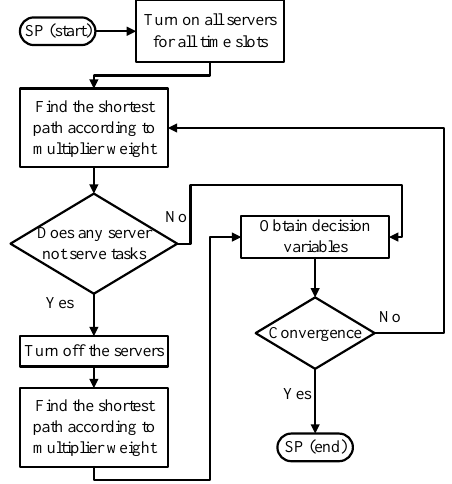
Figure 7. Flowchart of the SP